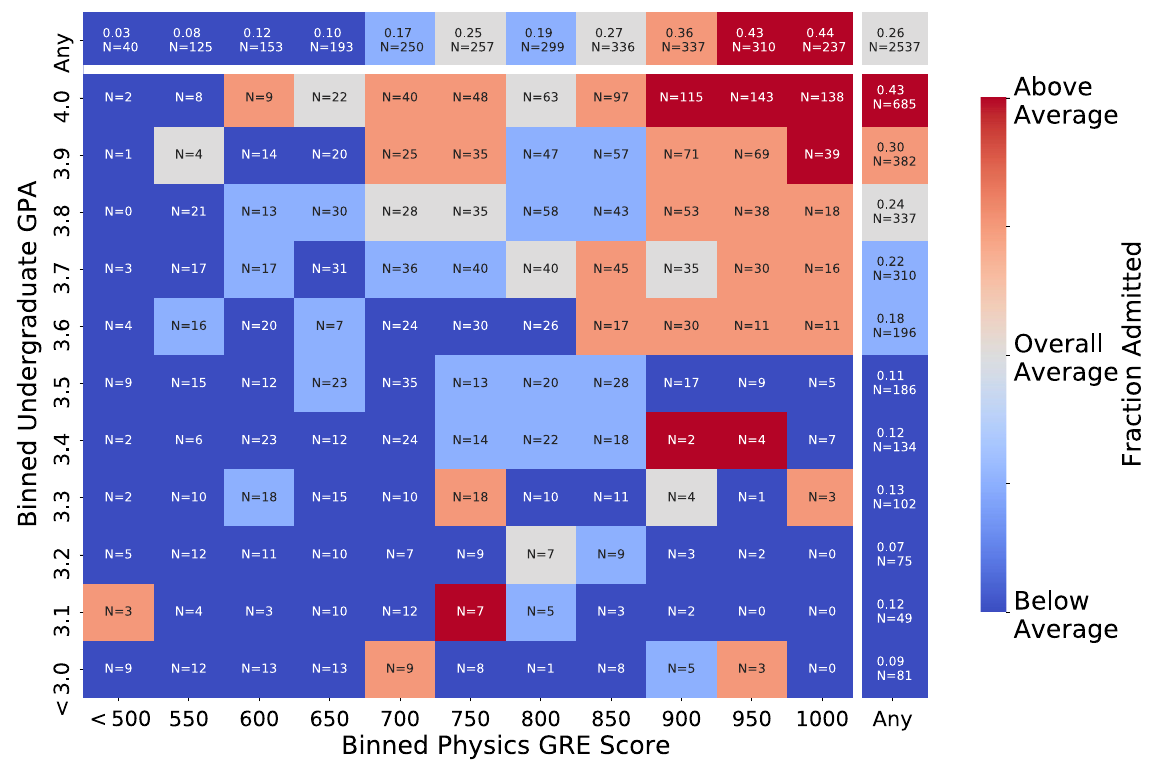
FIG. 3. Fraction of applicants admitted by undergraduate GPA and physics GRE score. The number of students in each bin is also shown. “ Any ” corresponds to the corresponding row or column totals. The bin label corresponds to the upper bound of values in the bin exclusive with the exception of the 4.0 GPA bin which includes 4.0. Values are colored based on whether they are above, below, or equal to the overall admissions rate. Admissions rates within 10% of the overall rate are colored the same as the overall rate. The above and below average colors are based on being above or below the midpoint between the max or min admission fraction and the overall average. These are based on raw numbers and not a statistical